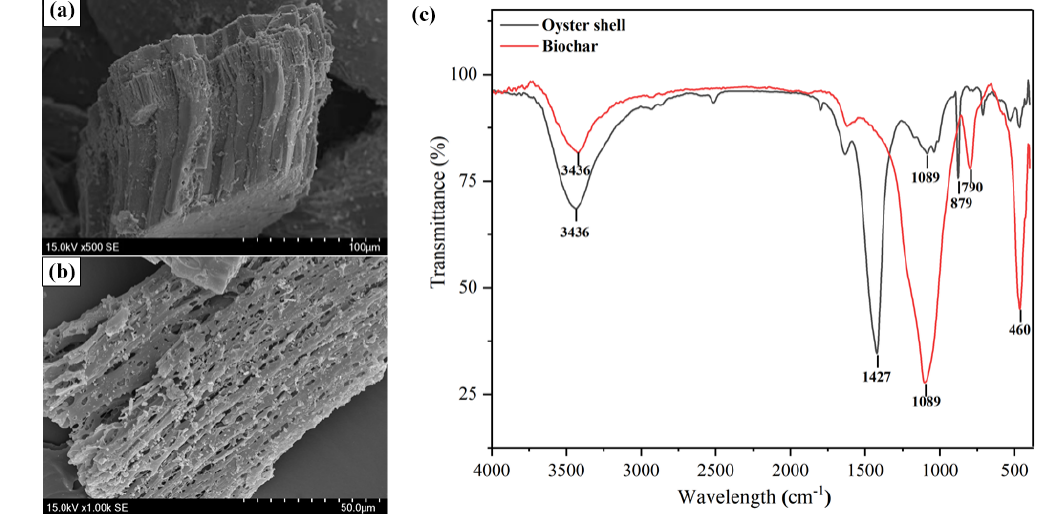
Figure 1. SEM images of oyster shell (a) and biochar (b) and FTIR spectra (c) of oyster shell and biochar.